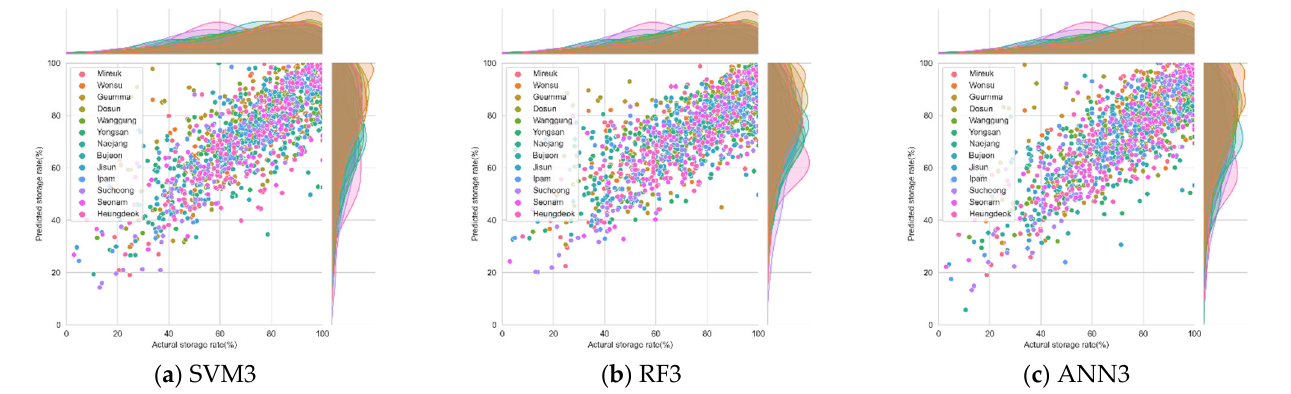
Figure 6. Scatter plots of the observed and predicted monthly storage rates by ( a ) SVM, ( b ) RF, and ( c ) ANN algorithms (three-month forecast). Table 10. Results of best parameters and learning time of models for three-month forecasting.